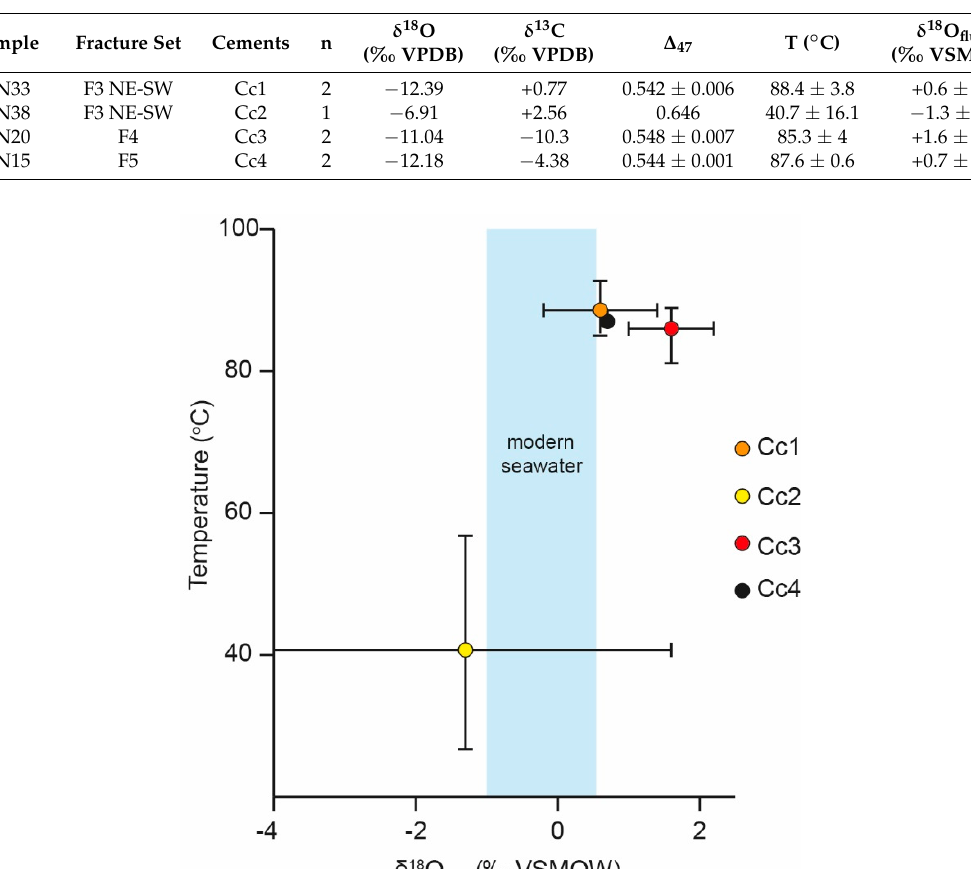
Table 2. δ 18 O, δ 13 C , Δ 47 , temperature and δ 18 O fluid values calculated from clumped isotope thermometry.